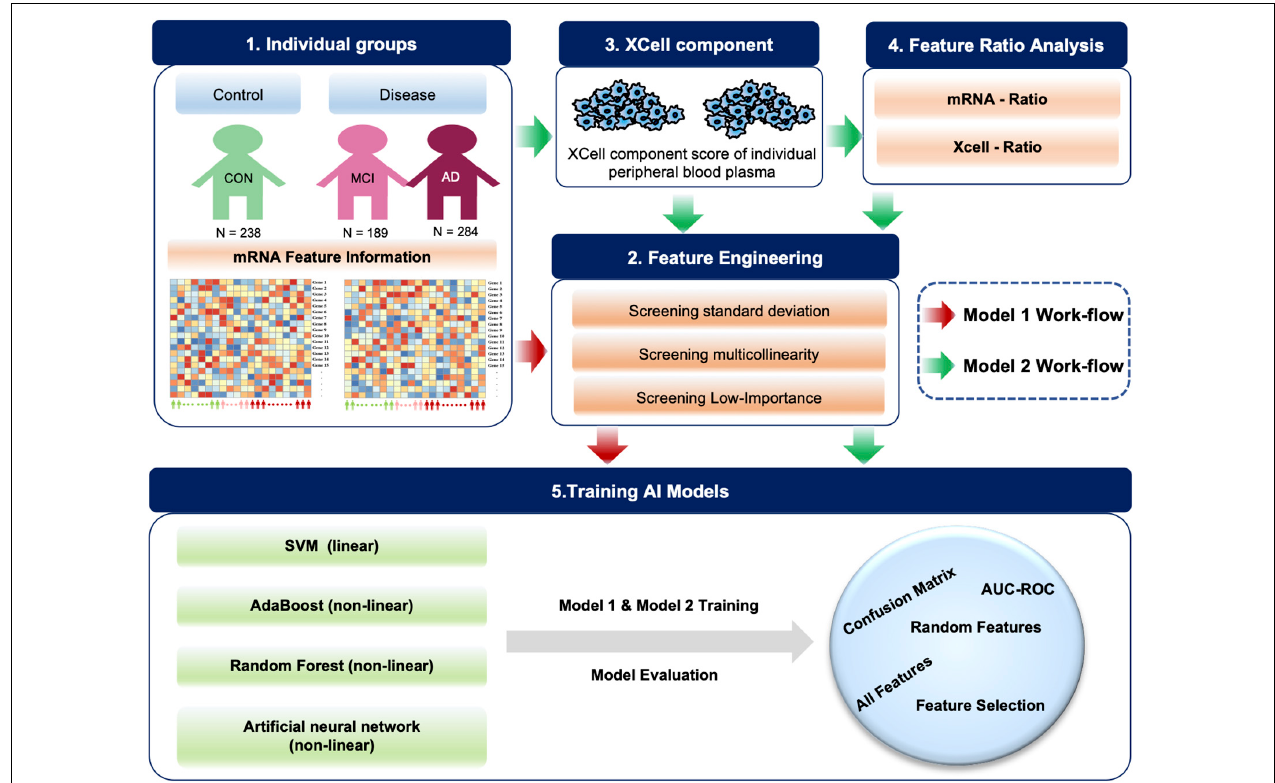
FIGURE 1 | Diagram of the workflow in this study. A total of 711 individual peripheral blood mRNA data were included for modeling and analysis, including 238 control (CON), 189 MCI and 284 AD samples. For Model 1, we performed feature engineering, training and testing. For Model 2, XCell cell composition was first decomposed from blood mRNA data, then feature ratios were calculated using XCell and mRNA features, respectively. We combined mRNA, XCell, mRNA-ratio, and XCell-ratio to perform feature engineering. Four different algorithms were used for AI modeling. The models were evaluated on test data using AUC-ROC and confusion matrix. The red arrows represent Model 1, and the green arrows represent the processes for Model